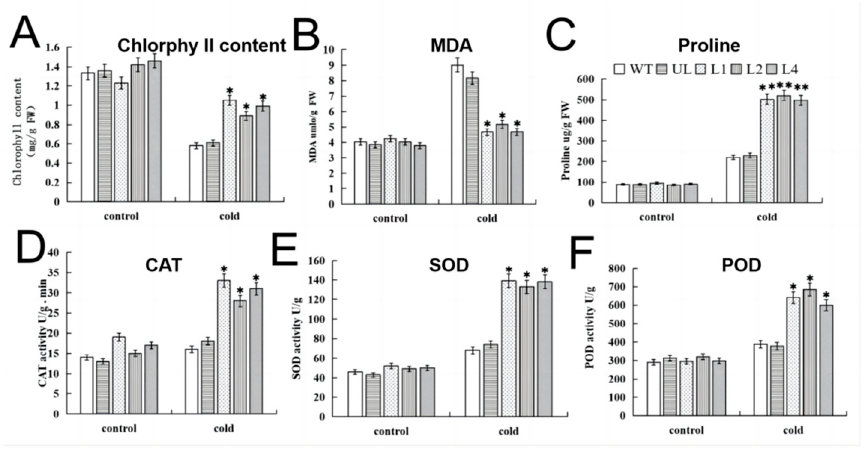
Figure 9. Effects of cold stress on physiological and biochemical indexes of FvMYB114 transgenic lines. After being treated with cold, the contents of ( A ) chlorophyll, ( B ) MDA and ( C ) proline and the activities of ( D ) CAT, ( E ) SOD and ( F ) POD in WT, UL, L1, L2 and L4 were determined. An asterisk marks the SD between transgenic lines and WT (* p ≤ 0.05, ** p ≤ 0.01). The control group set the level of each index in WT.